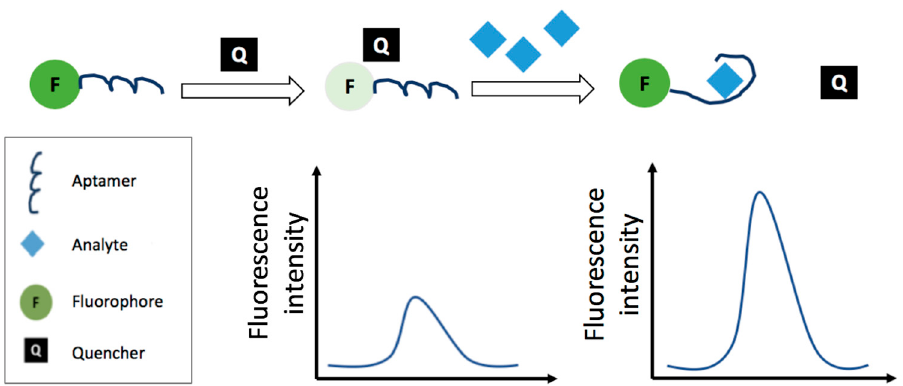
Figure 5. Schematic representation of fluorescence detection strategy employing an aptamer; the strategy is based on the fluorophore fluorescence quenching by the use of a quencher .